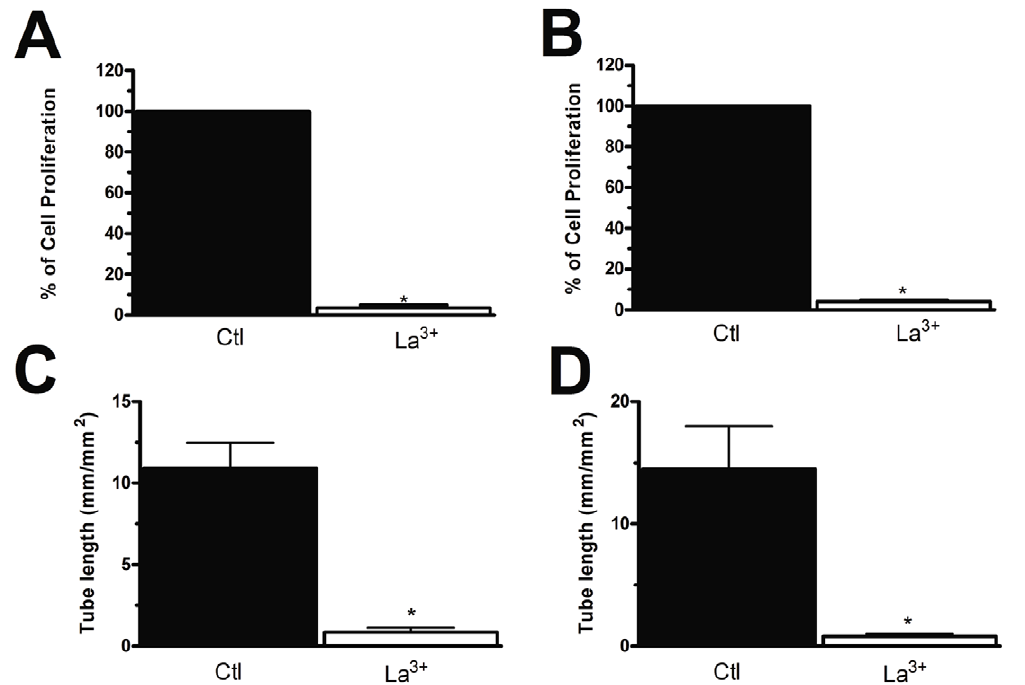
Figure 11. La 3 + impairs proliferation and tubulogenesis of endothelial progenitor cells. La 3 + (10 m M) suppresses proliferation in both N- EPCs (A) and RCC-EPCs (B). Results are expressed as percentage of growth compared with control (given as 100% growth). Similarly, La 3 + (10 m M) interferes with the tubule-formation capacity of both N-EPCs (C) and RCC-EPCs (D).